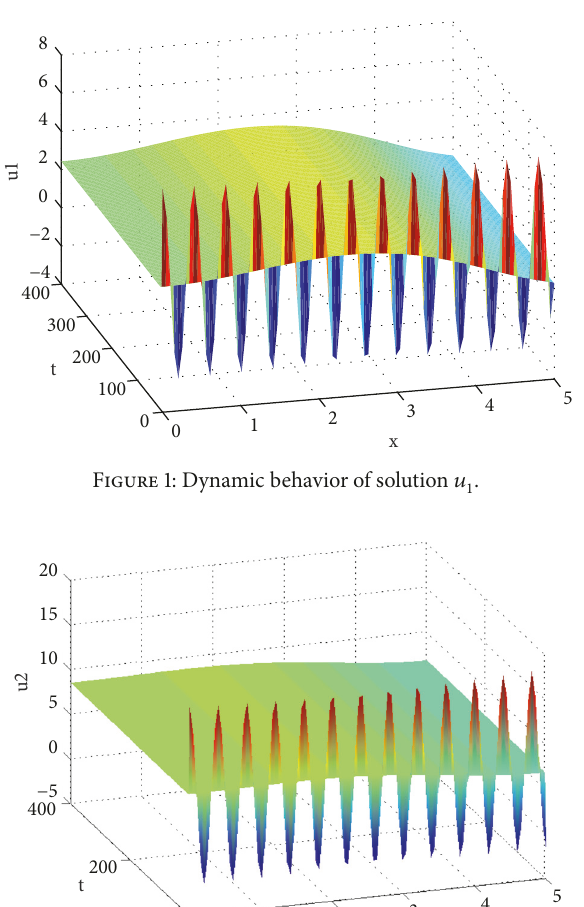
Figure 4: Dynamic behavior of solution V 2